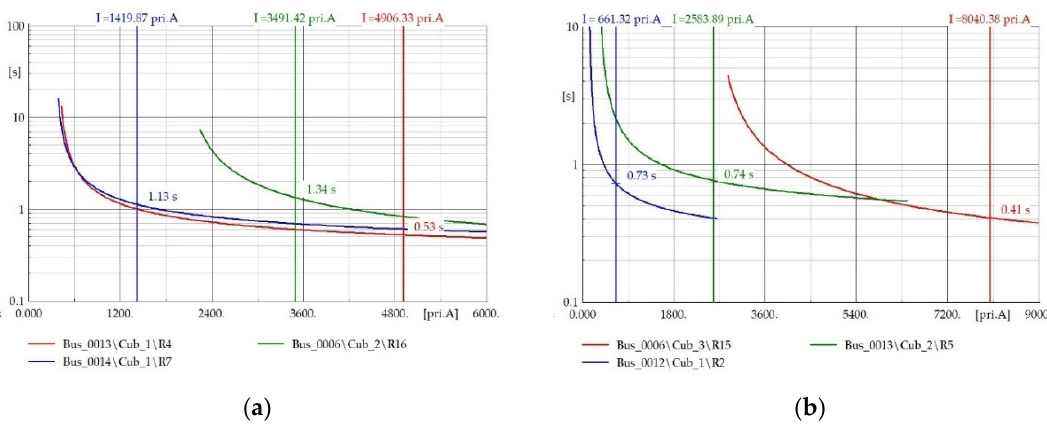
Figure 9. ( a ) T10, R4 (red) primary operation with backup R16 (green) and R7 (blue) obtained with cluster 3 settings; ( b ) T13, R15 (red) primary operation with backup R5 (green) and R2 (blue) obtained with cluster 3